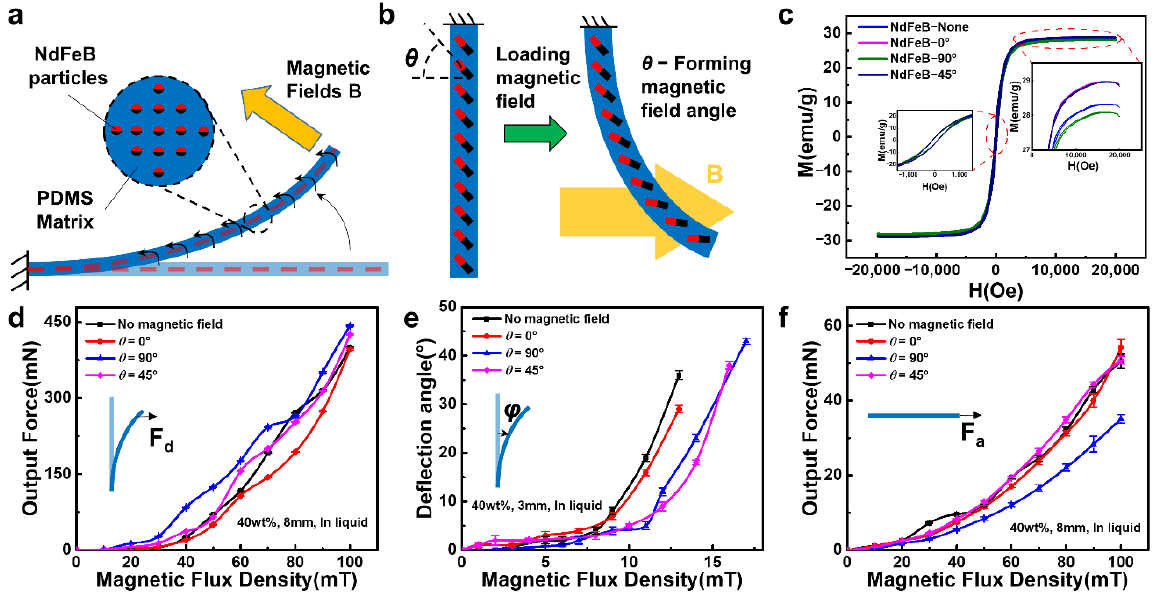
Figure 3. Driving mechanism and performance of the FIP: ( a , b ) Driving mechanism of the FIP, ( c ) Hysteresis line of the MD part, ( d ) Deflection output force curve of the FIP, ( e ) Deflection angle curve of the FIP, ( f ) Axial output force curve of the FIP.